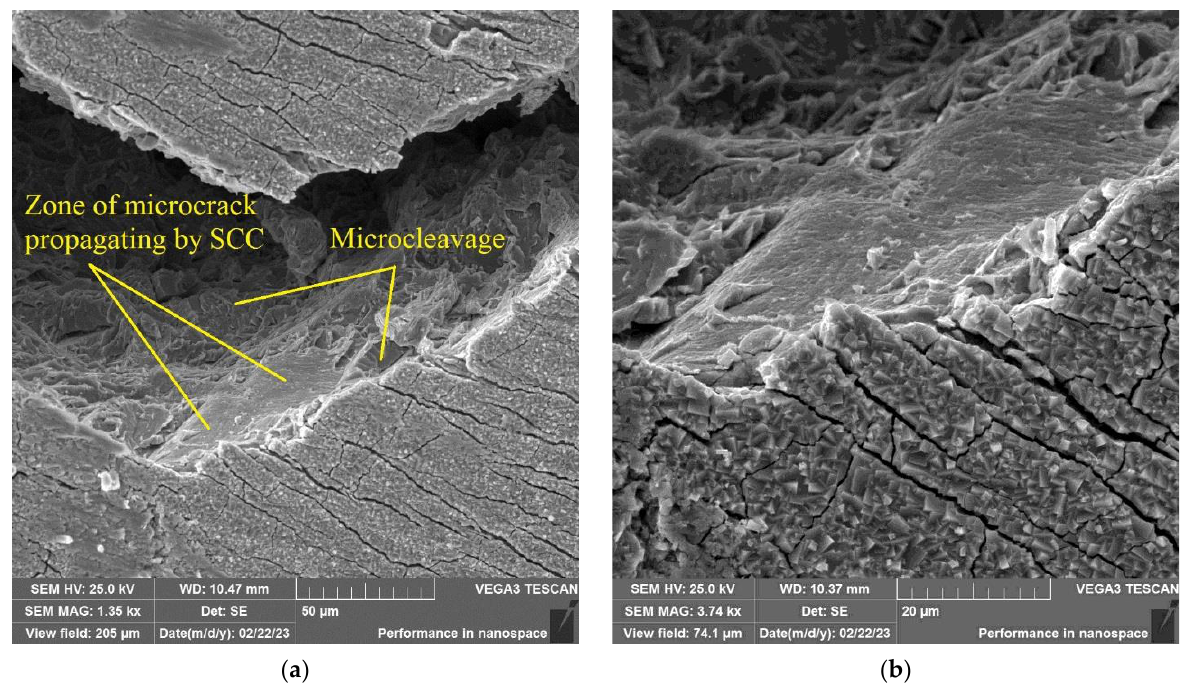
Figure 25. Surface of disk specimen (Tirr = 390 °C) after autoclave SCC tests with a load value of 801 N and subsequent fracture at minus 140 °C. Zone of microcrack propagating by SCC mechanism at different magnifications ( a , b ) is shown. Microcleavage mode typical for brittle fracture of F/M steel is shown too.